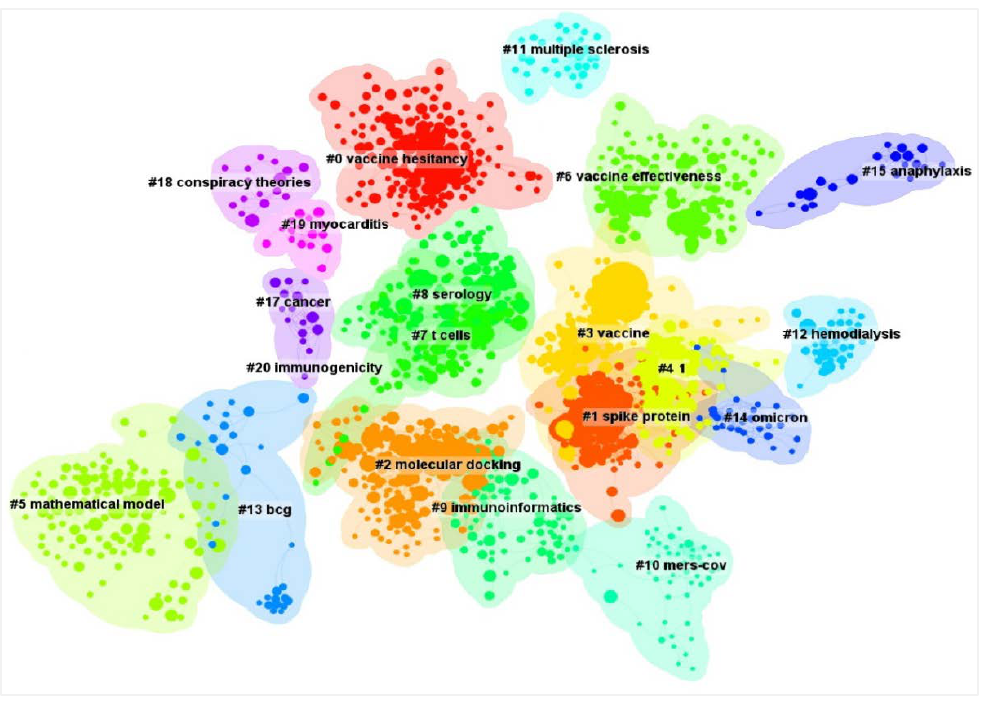
Figure 6. The reference co-authorship clusters visualization map in COVID-19 vaccine research, by CiteSpace analysis. All clusters were labeled by keywords extracted from the references.